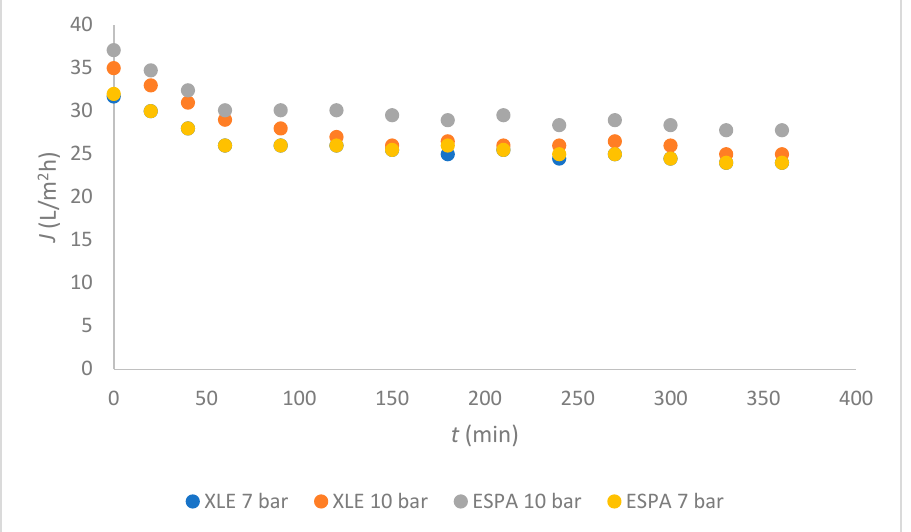
Table 4. Measured chemical parameters in the wastewater mixture (mixWW).